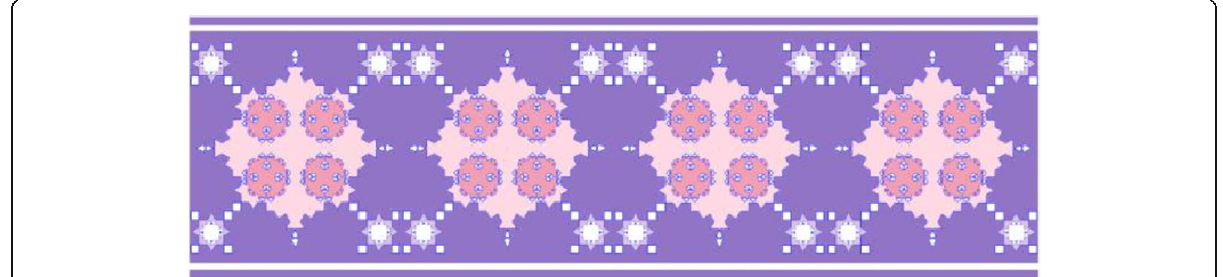
Fig. 12 The two-dimension series vertical-type